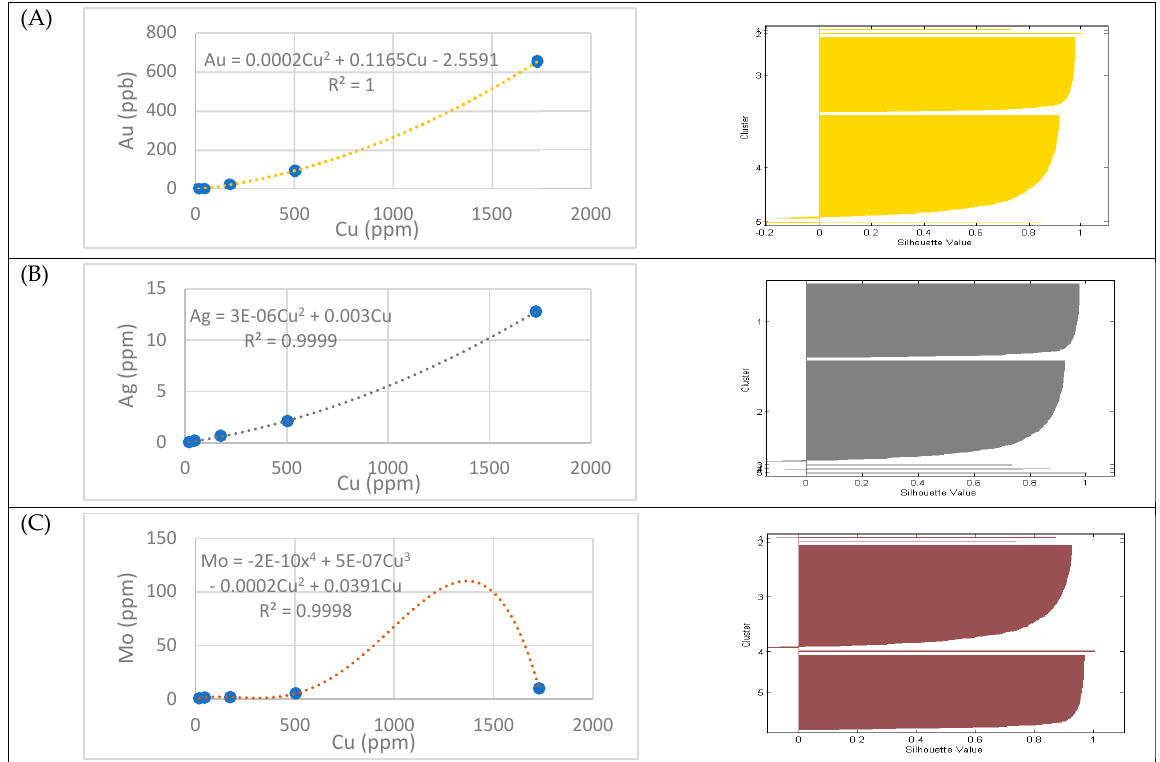
Minerals 2022 , 12 , x FOR PEER REVIEW 13 of 24 Figure 11. The profile of the clusters and the behavior of Cu and Au, Ag, Mo and concentrations in the centers of clusters. ( A ) Au-Cu, ( B ) Ag-Cu, ( C ) Mo-Cu.